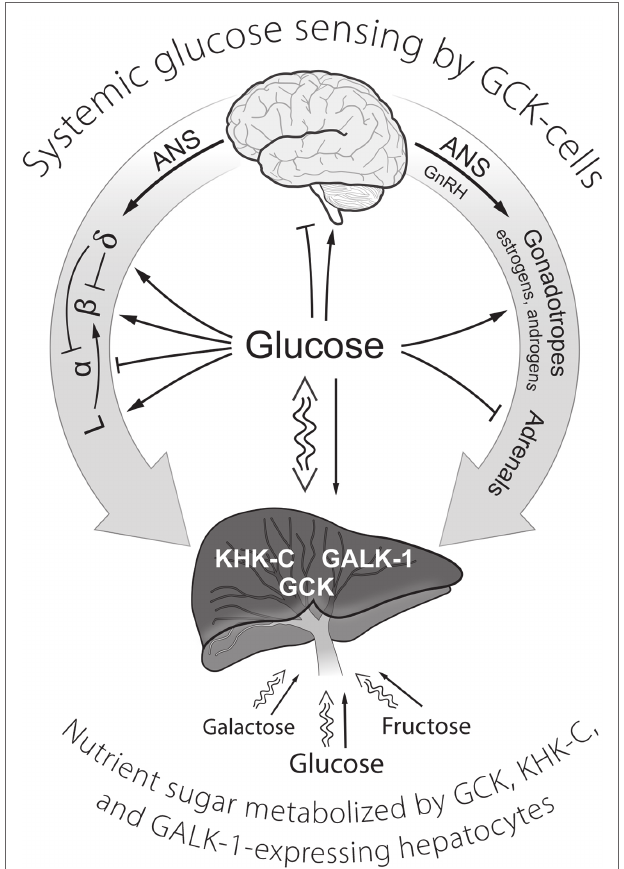
FIGURE 1 | A schematic representation of GCK containing cells in sensing systemic glucose and regulating glucose homeostasis. Systemic glucose concentration is sensed by cells through its metabolism by GCK and the rate of production of G-6-P on cellular energy state. Cell-specific mechanisms then translate alterations in energy state into responses (hormone release, neural activity) that either augment or inhibit glucose consumption and/or production of glucose as appropriate to maintenance of homeostasis. The central role of the liver in metabolizing dietary sugars (glucose, galactose, and fructose), nearly quantitative removal of the galactose and fructose, is noted. ANS, autonomic nervous system; GCK, glucokinase; GALK-1, galactokinase-1; KHK-C, ketohexokinase-C (i.e., fructokinase); GLP-1-producing enteroendocrine L-cells; GnRH, gonadotropin-releasing hormone; α , β , δ , the alpha, beta, and delta cells of pancreatic